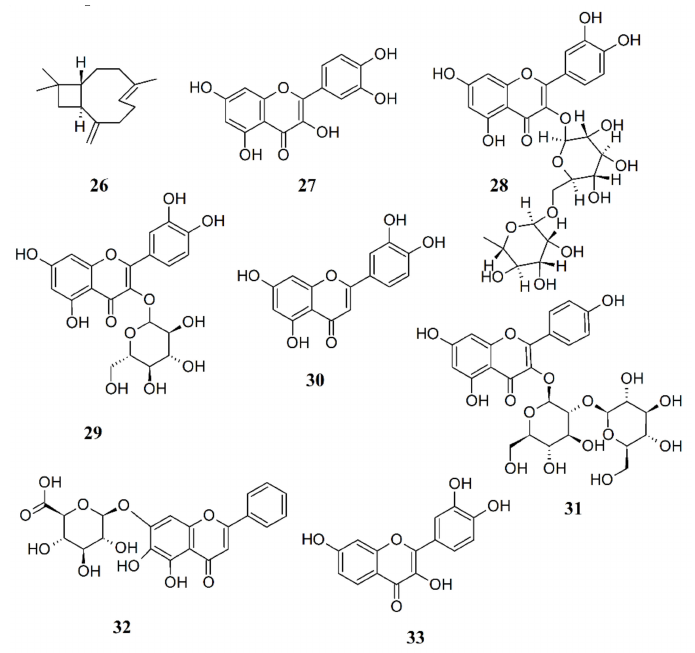
Figure 7. Chemical structure of some natural compounds with antinociceptive